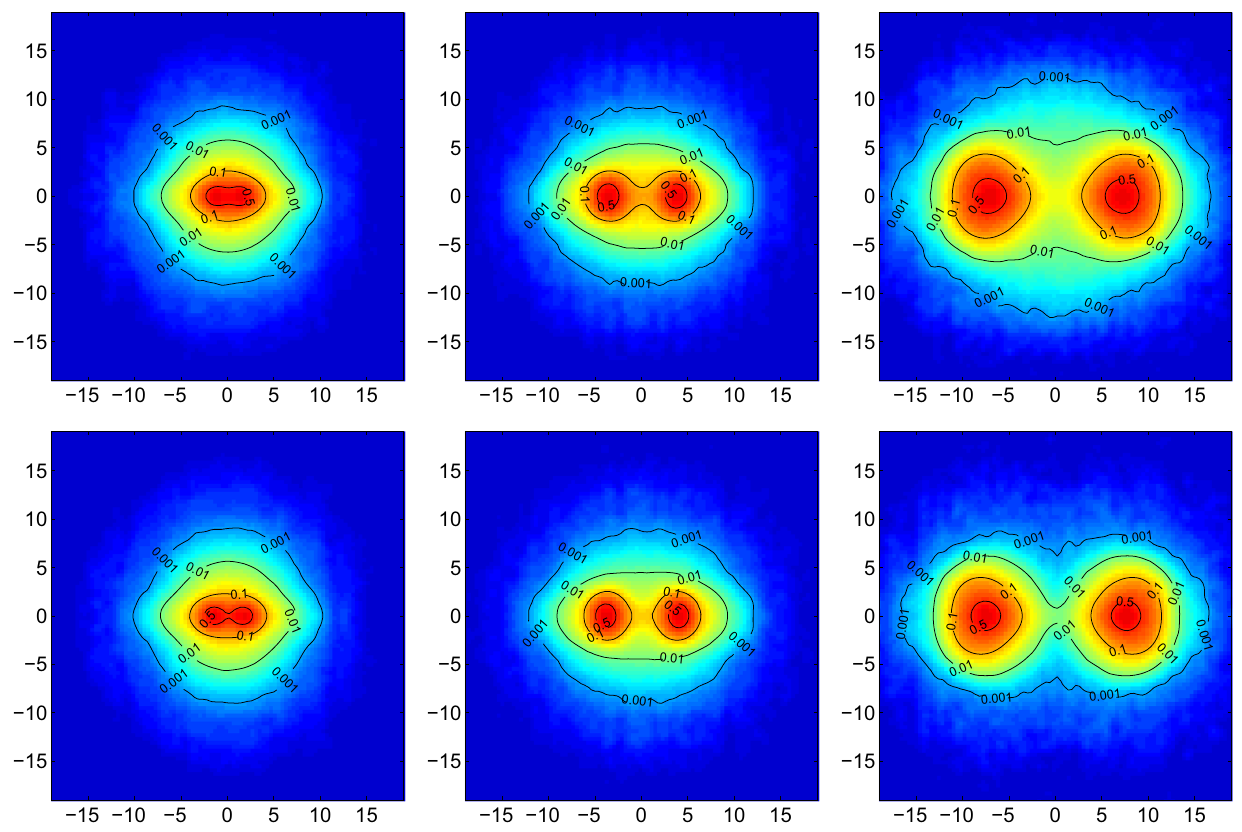
Fig. 6 The difference in the post-collision mass distributions of fast symmetric galaxy cluster collisions with weakly scattering DM and k = 2 . 0. Top row shows the post-collision mass distribution with weakly scattering DM and the bottom row shows the same for stan- dard CDM. Left panels show the mass distributions at early separation